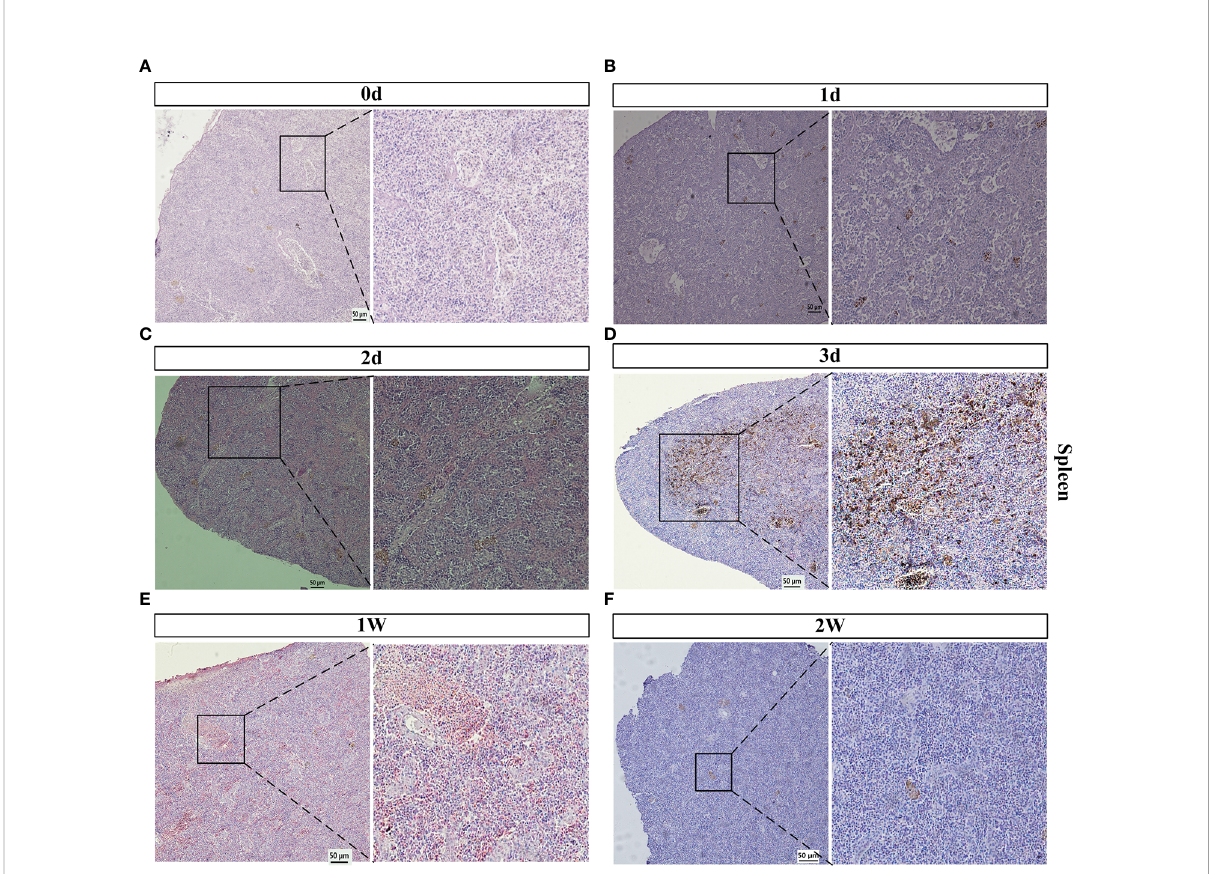
FIGURE 2 Spleenhistopathology analysesof V. Parahaemolyticus arti fi cially infectedwith E. coioides . (A – F) The spleensliceof E. coioides arti fi ciallyinfectedwith V. parahaemolyticus for0d(Control), 1d, 2d,3d, 1w,2 w. Representativeimagesfromatleastthreebiological